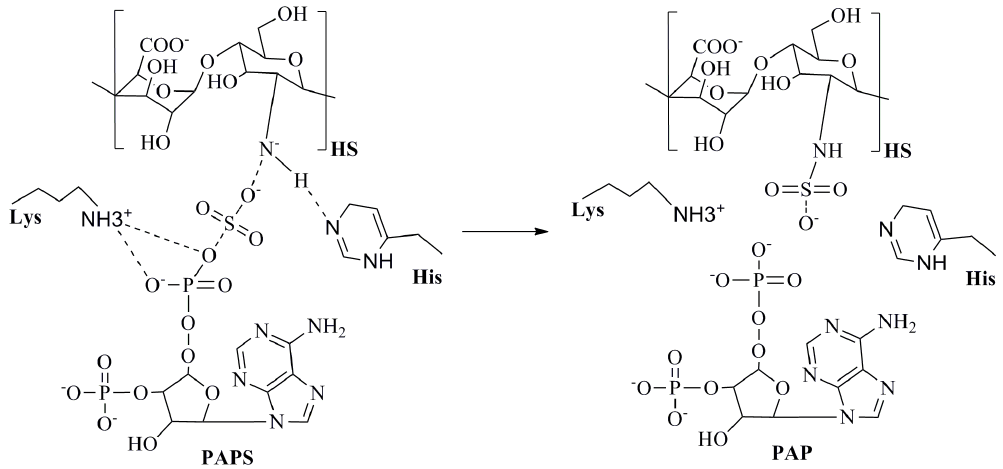
Figure 1. General reaction catalyzed by the NSTs.